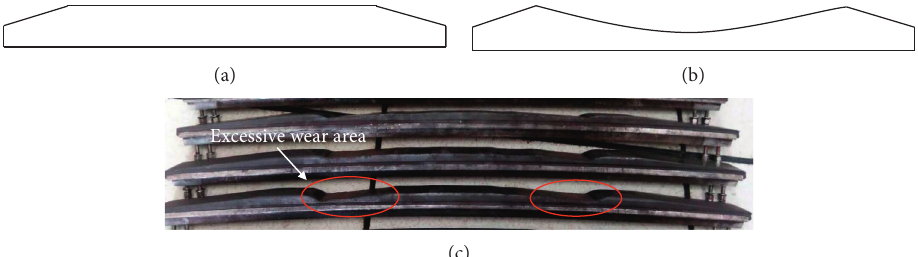
Figure 9: Comparison of carbon strip wear traces. (a) New carbon strip. (b) Carbon strip after abrasion (ideal case). (c) Carbon strip after abrasion (reality).